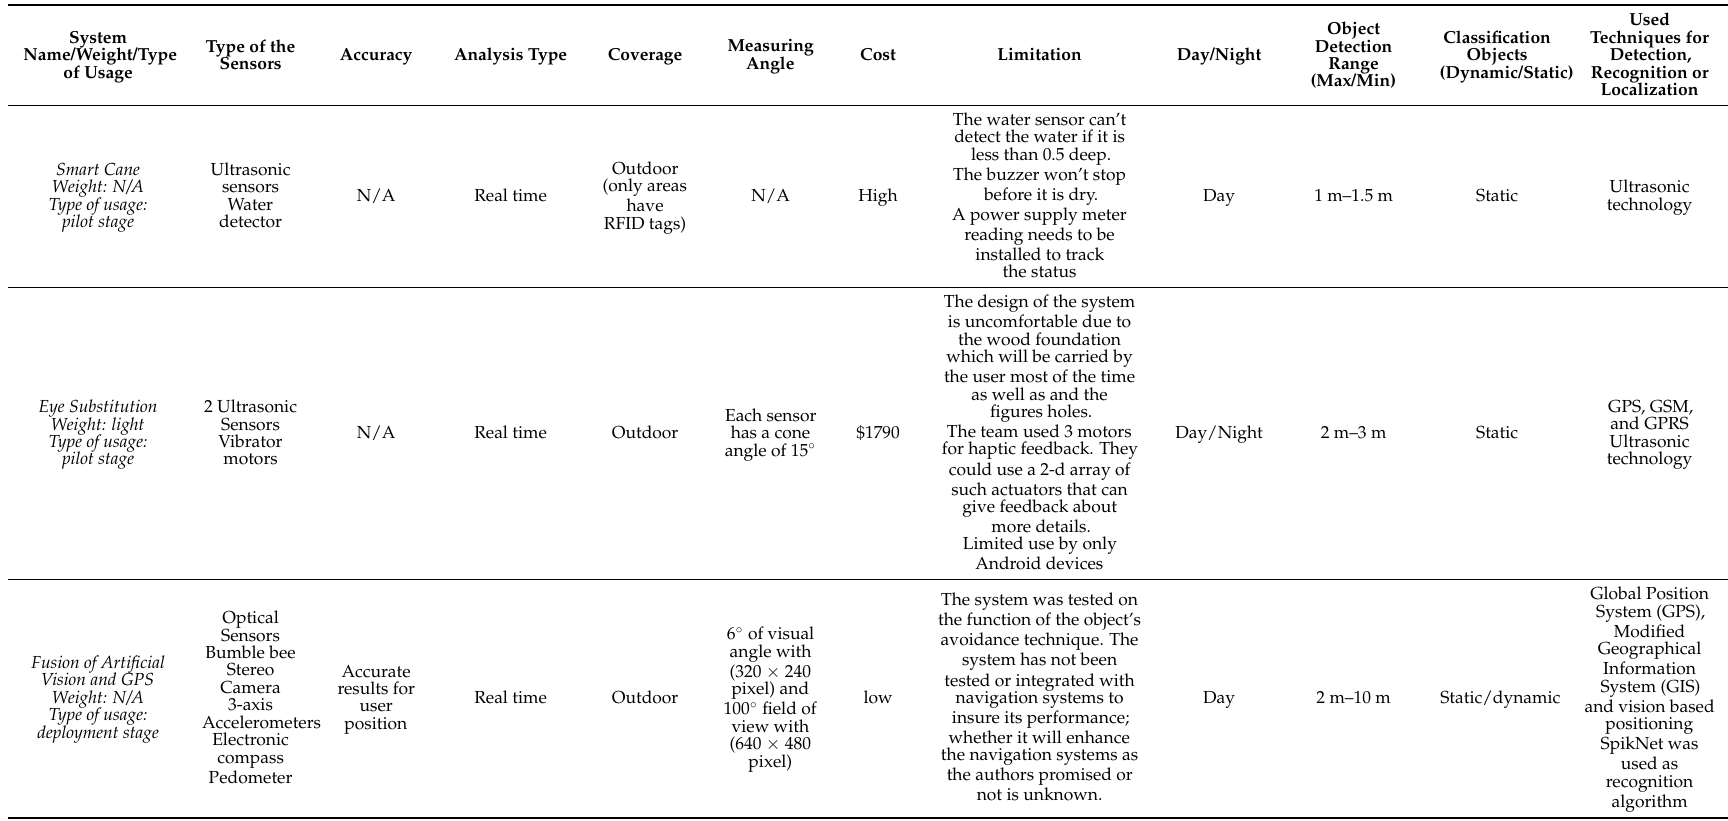
Table A1. Evaluation of reviewed systems based on addition features that caused that limitations of each